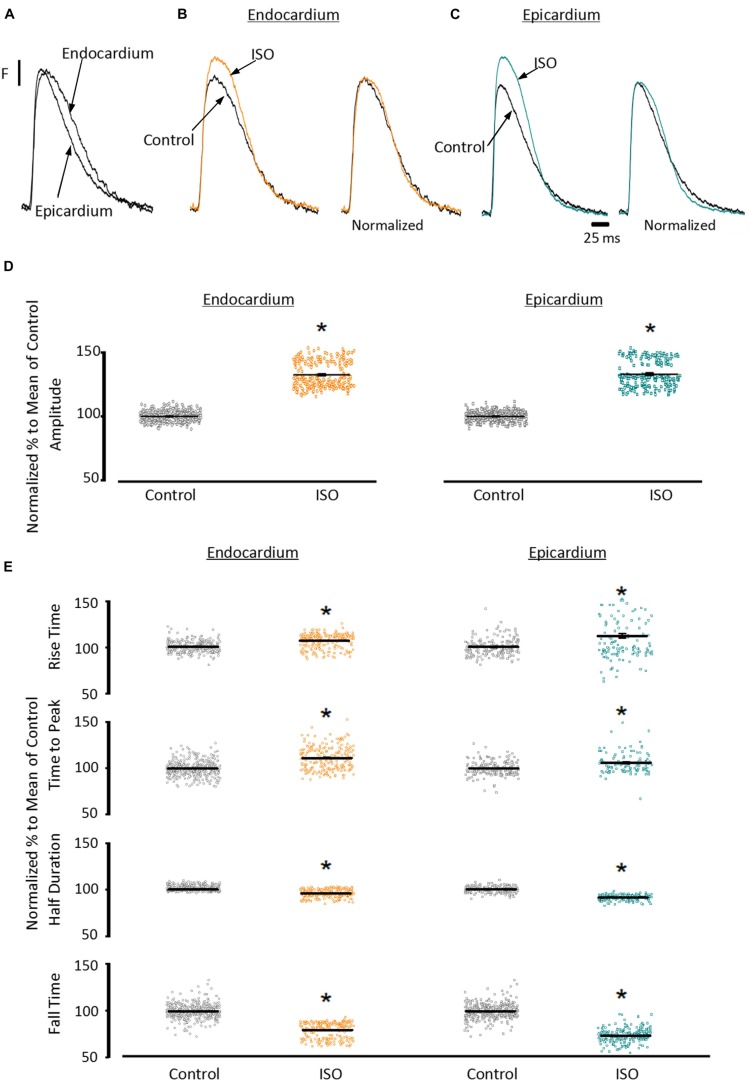
β-Adrenergic stimulation modulates Ca2+ transients in endocardium and epicardium. (A) Normalized fluorescent Ca2+ transients recorded, simultaneously, from endocardium and epicardium using Rhod-2 and the pulsed local field fluorescence microscopy technique. (B) Representative fluorescent traces of the endocardial Ca2+ transients before (black) and after 500 nM isoproterenol (ISO; orange). Right panel: Ca2+ transient traces normalized to their corresponding maximum fluorescence. (C) Representative Ca2+ transients recorded from the epicardium before (black) and after isoproterenol (cyan). Right panel: Ca2+ transients normalized to their maximum fluorescence. (D) Summary of the normalized amplitude of the Ca2+ transient changes, from the endocardium (circles) and epicardium (squares), before and after isoproterenol. (E) Data showing the kinetic changes in the normalized Ca2+ transients before and after isoproterenol. Means ± SEM are represented as the solid horizontal lines. *p < 0.01, N = 4 hearts.